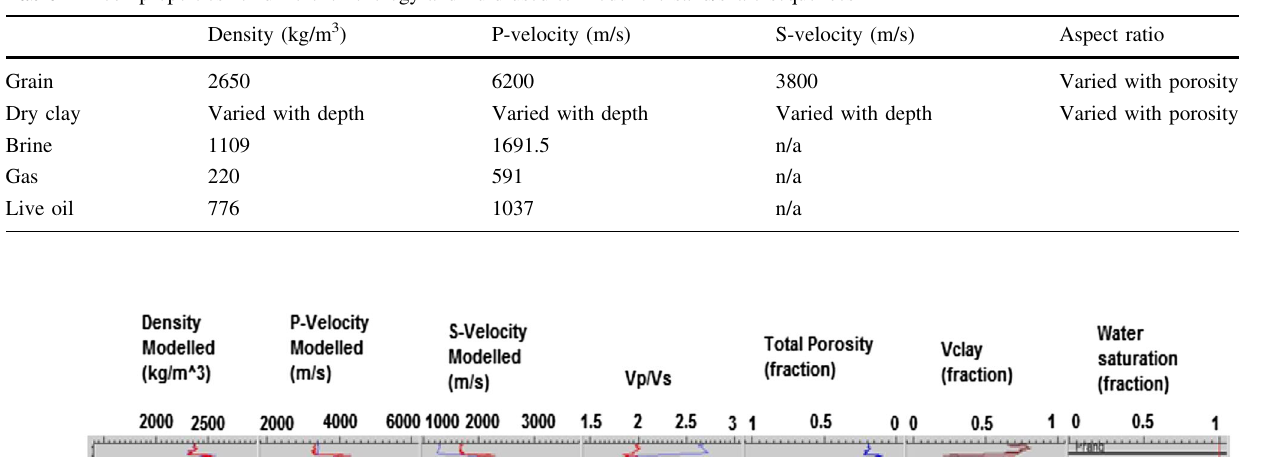
Table 4 Rock properties for different lithology and fluid used to model the sand/shale sequences